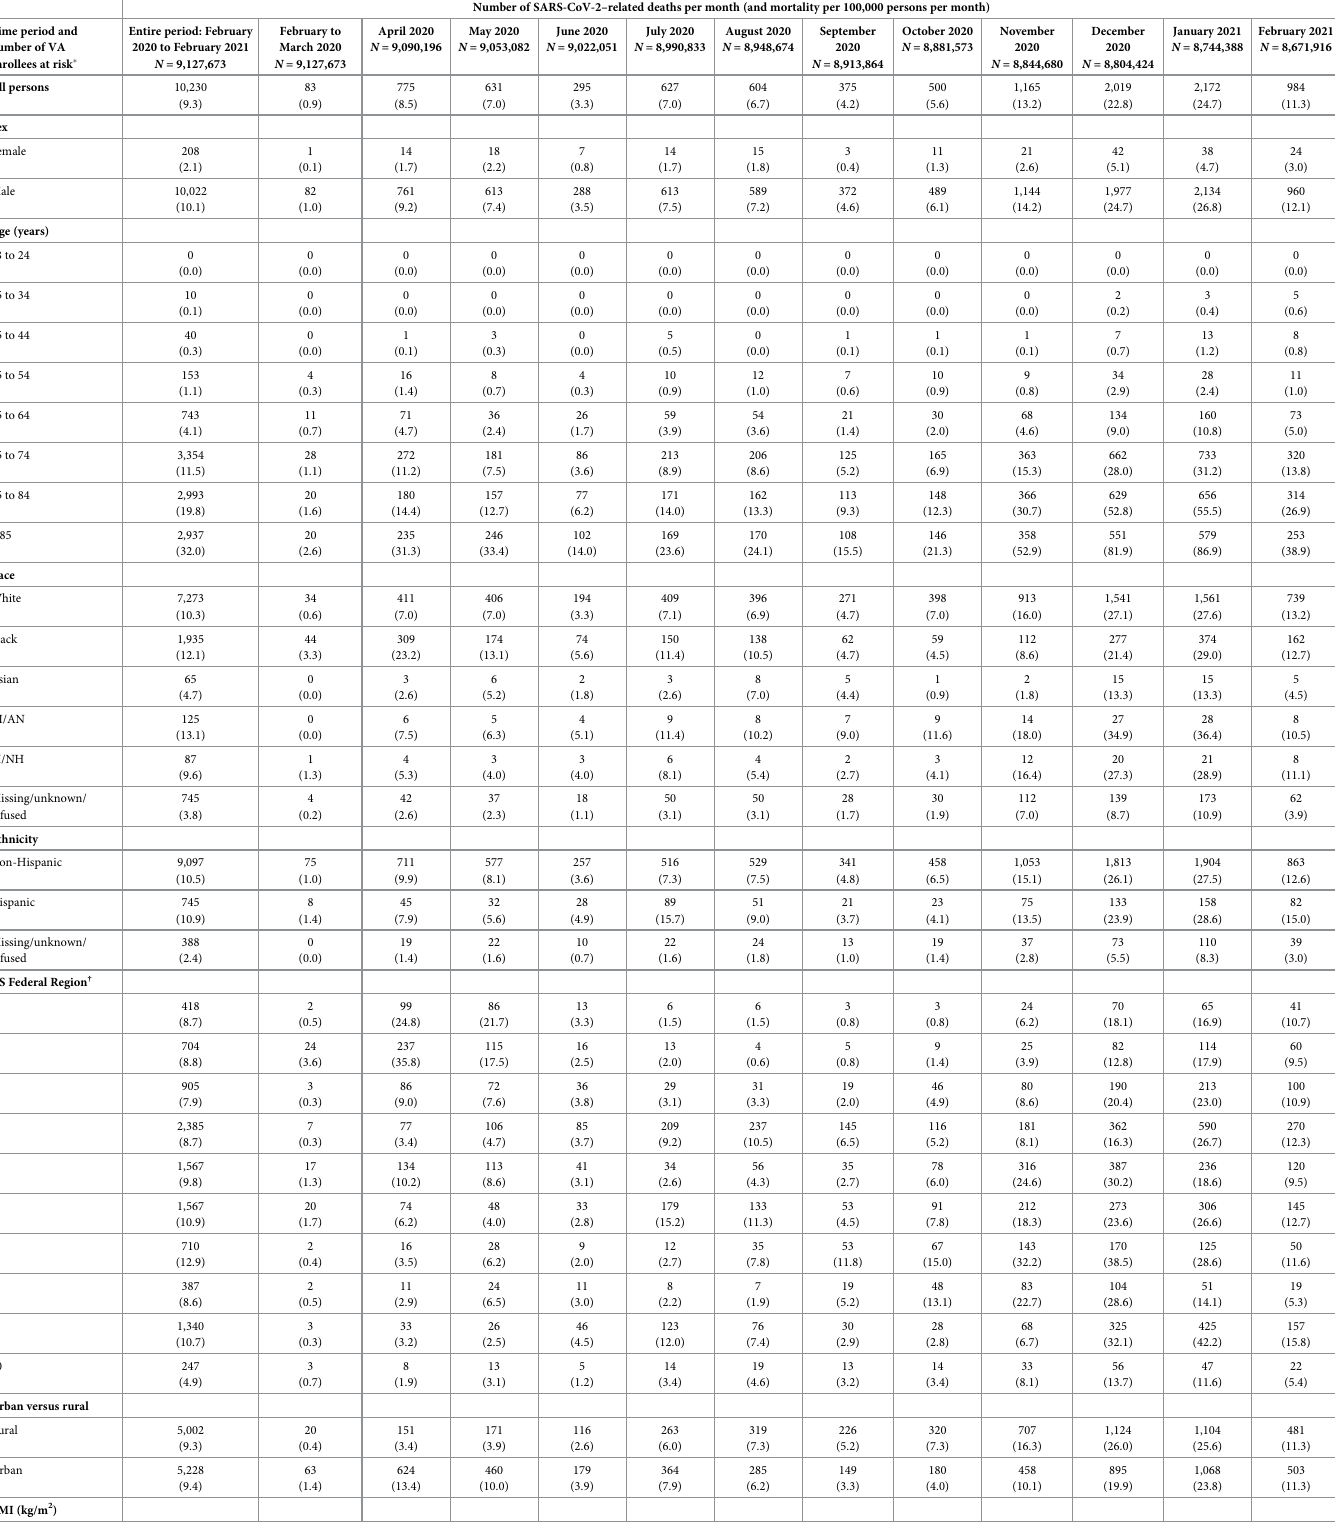
Table 3. SARS-CoV-2–related mortality presented by month in a cohort of 9.1 million VA enrollees followed from February 2020 to February 2021.